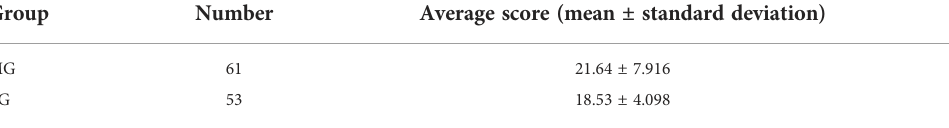
MG, morning radiotherapy group; EG, evening radiotherapy group.